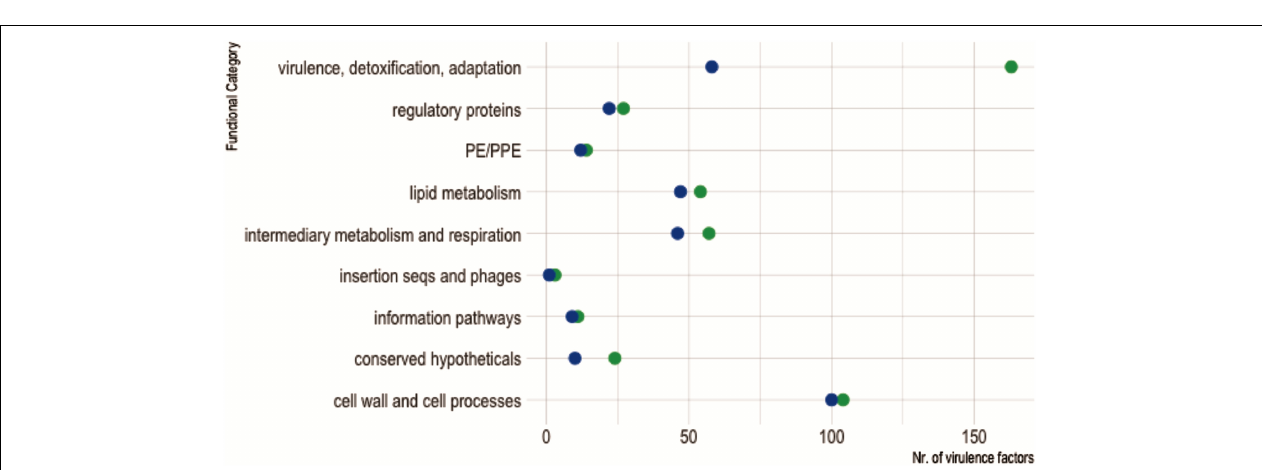
FIGURE 7 | Morphometric analysis of lung pathology in animals infected with Mycobacterium kansasii strains. For morphometric determination of the inflammatory area occupied in the lungs by cellular or liquid exudates (pneumonia area), images of ten lung sections of each group of animals were captured and analyzed using the Image J program. Statistically significant differences between each group infected with the individual clinical isolate and the respective group infected with reference strain 12478 are presented by asterisks as follows: *** P < 0.001 and ** P < 0.01.